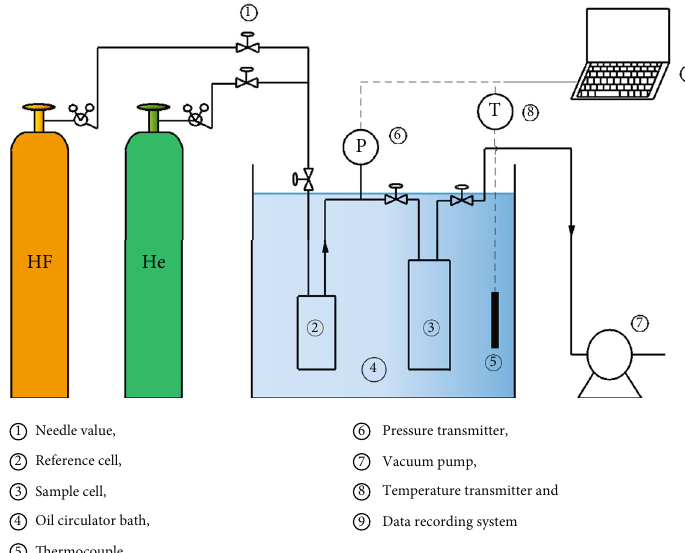
Figure 1: A schematic of experimental setup for HF adsorption.